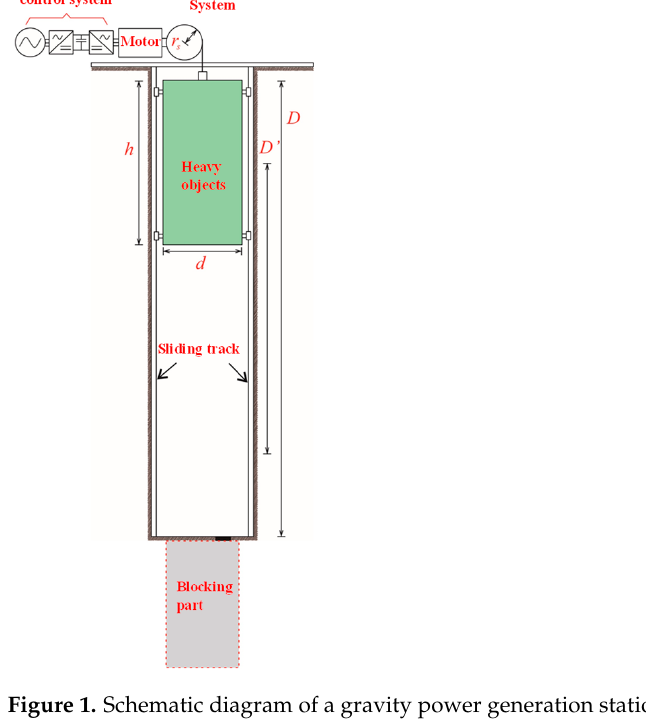
Figure 1. Schematic diagram of a gravity power generation station.